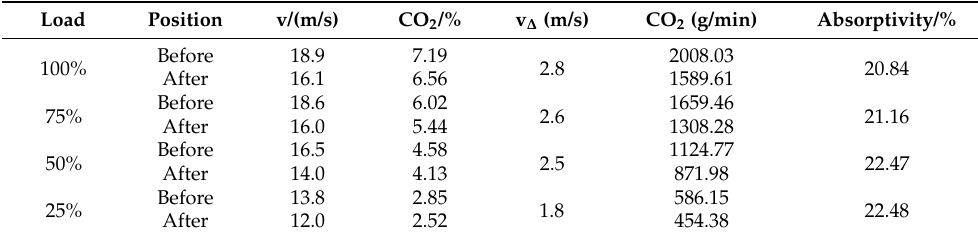
Table 10. Effect of exhaust gas velocity on CO 2 absorption rate (spiral nozzle).